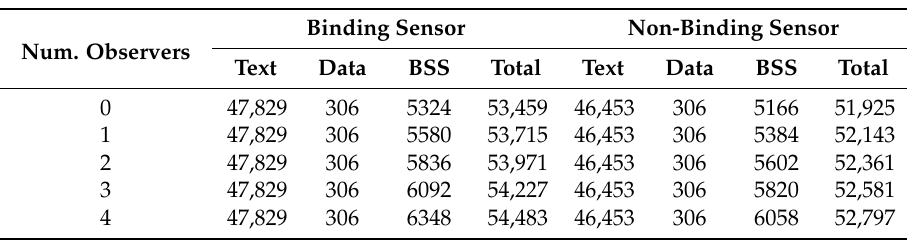
Table 1. Memory Foot